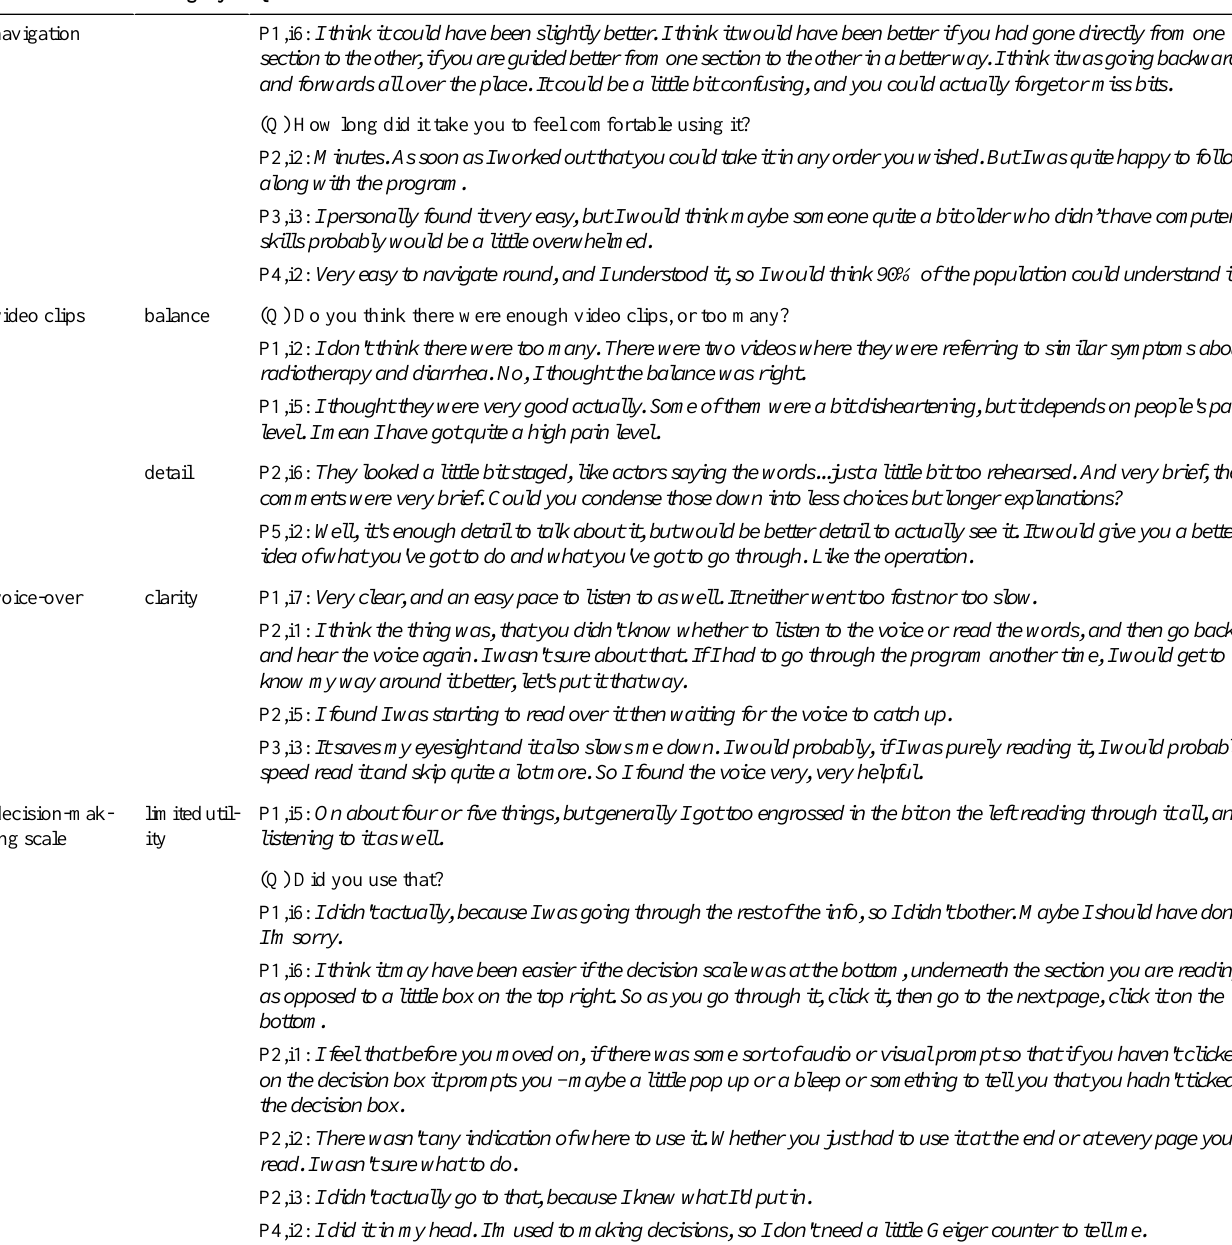
Table 4. Theme 2: Responses to Specific Features of Prosdex - Categories and Quotations